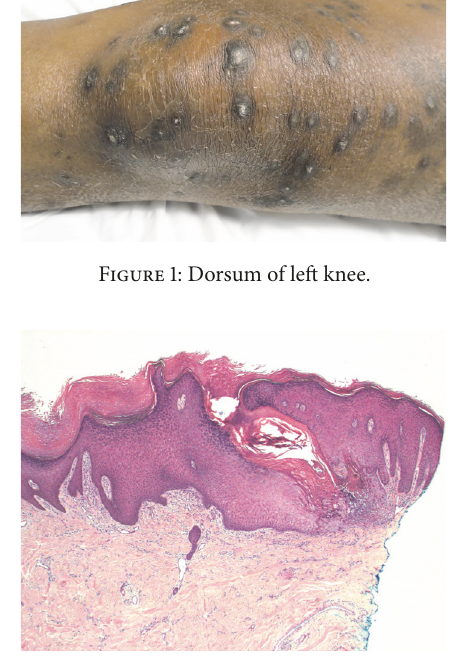
Figure 2: Low magnification view showing irregular epidermal acanthosis, with a prominent transepidermal defect containing cellular debris (hematoxylin and eosin stain, original magnification × 40).